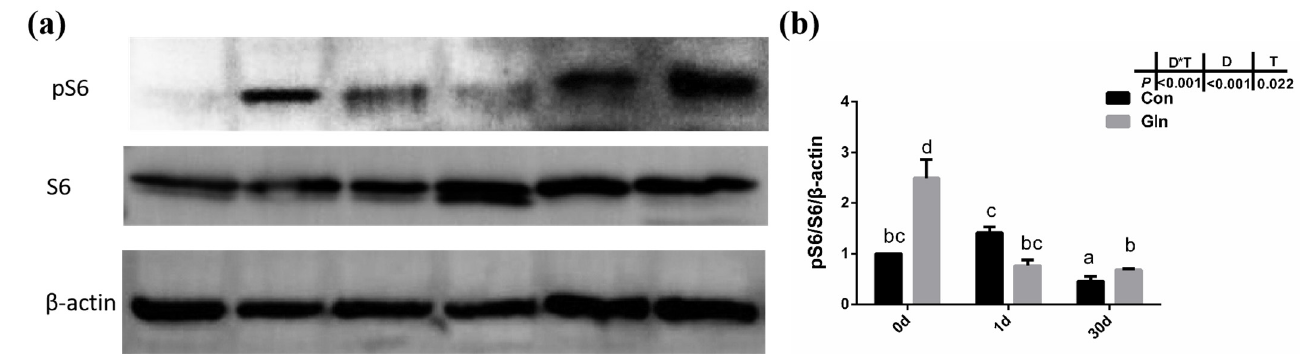
Figure 7. The effects of dietary glutamine on the mTOR signaling pathway activation of yellow catfish during F. columnare infection. ( a ) Western blotting analysis of pS6 and S6 in yellow catfish in both control group (Con) and glutamine supplementation group (Gln) at 0 d, 1 d and 30 d after F. columnare infection. ( b ) The ratio of pS6/S6/ β -actin protein level in yellow catfish among all treatments. All data was analyzed with two-way ANOVA and data are means ± SD ( n = 6). Mean values with different letters indicated significant differences among groups, p < 0.05.